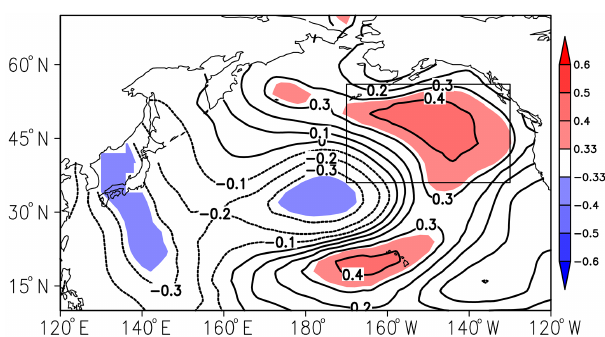
Figure 5. The CC between predictor x 2 and wind vector DY at 200hPa in winter from 1980 to 2013. The shades indicate that the CC between the zonal wind DY and x 2 exceeded the 95% confi- dence level.